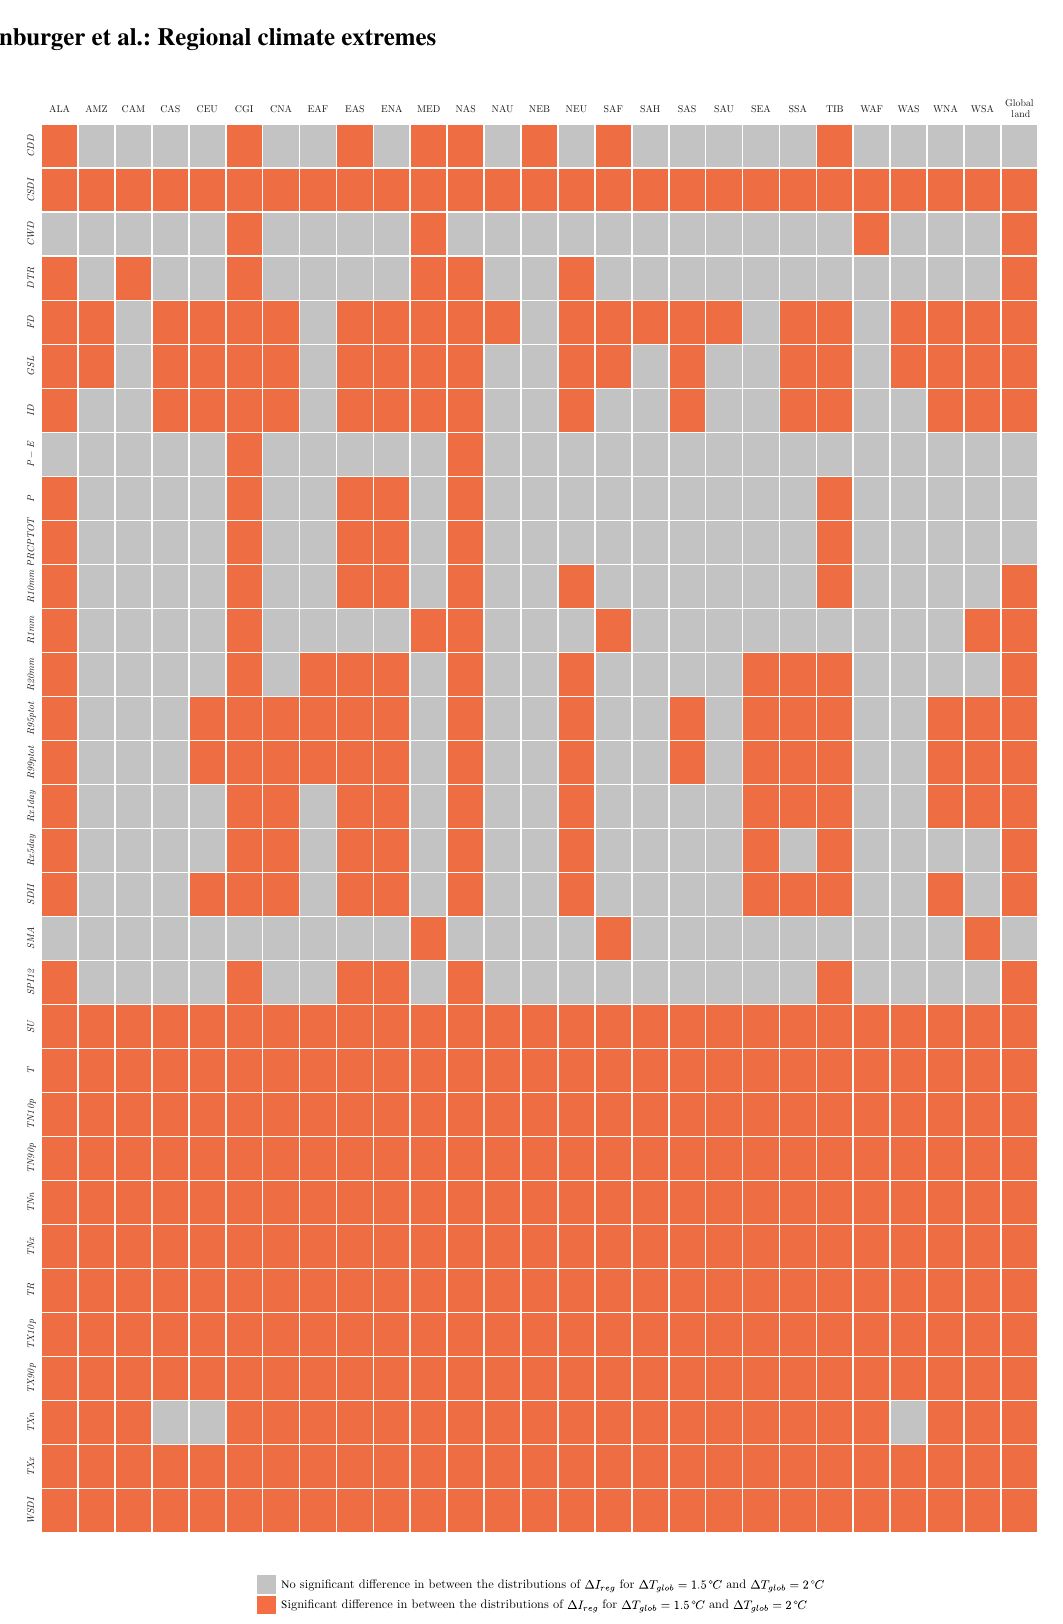
Figure 7. Significance of differences of (cid:49)I reg in between the 1 . 5 and 2 ◦ C global mean temperature targets based on mean temperature T , mean precipitation P , the drought indices defined in Sect. 2.2, and all ETCCDI indices as defined in Sillmann et al. (2013a) (rows). Columns indicate SREX regions (according to IPCC AR5; http://www.ipcc-data.org/guidelines/pages/ar5_regions.html) and global